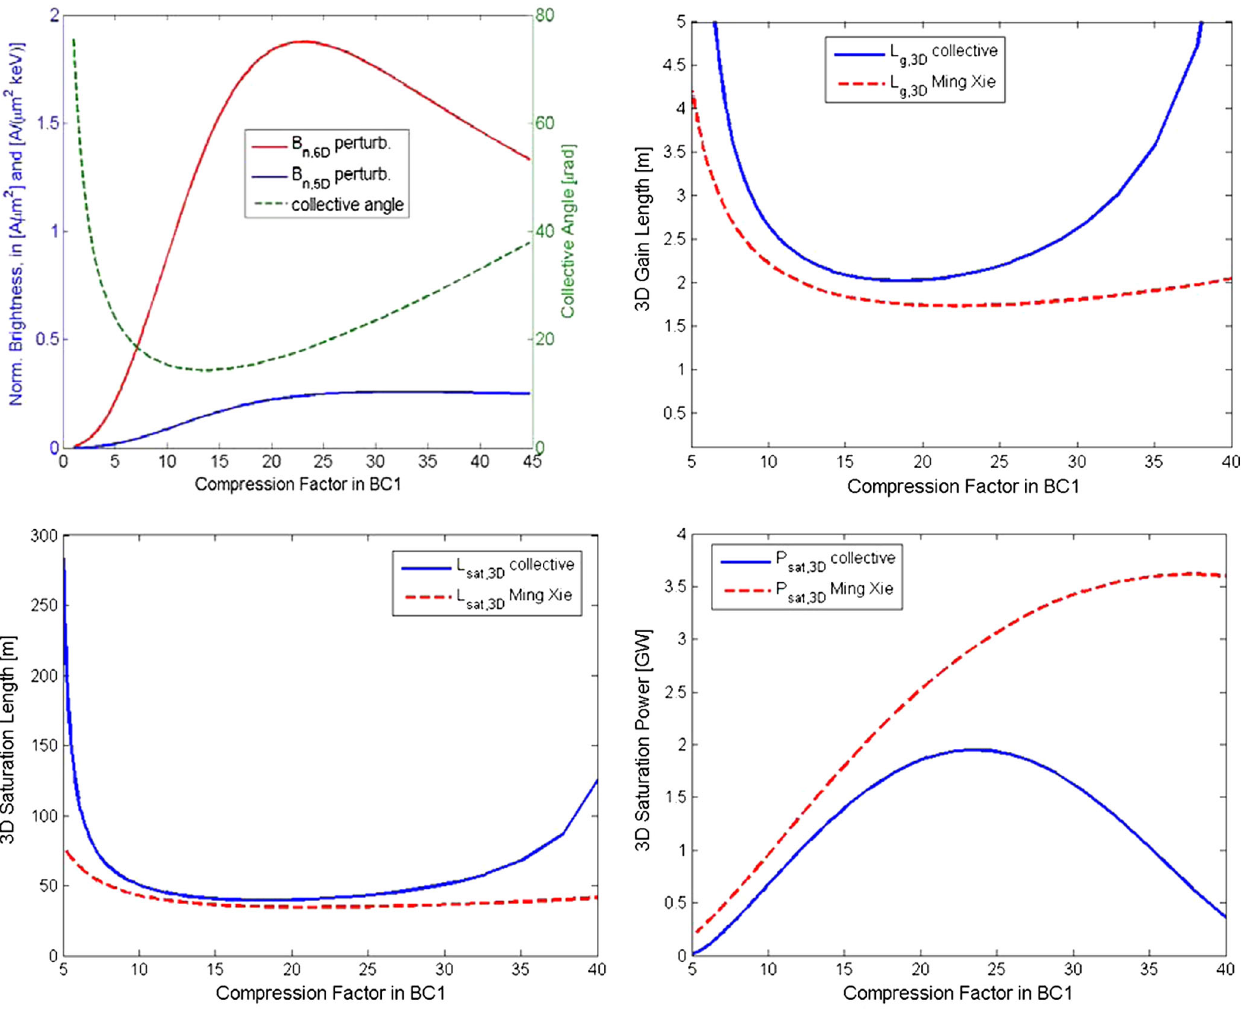
FIG. 8. The final 5D and 6D normalized brightness and the collective angle [Eq. (2)] are evaluated vs the compression factor in BC 1 (top left panel), for a 500 pC bunch charge compressed in SL with one stage. The 3D gain length (top right), the 3D SASE saturation length (bottom left), and the 3D SASE saturation power are evaluated in the Xie sense and in the presence of collective effects,